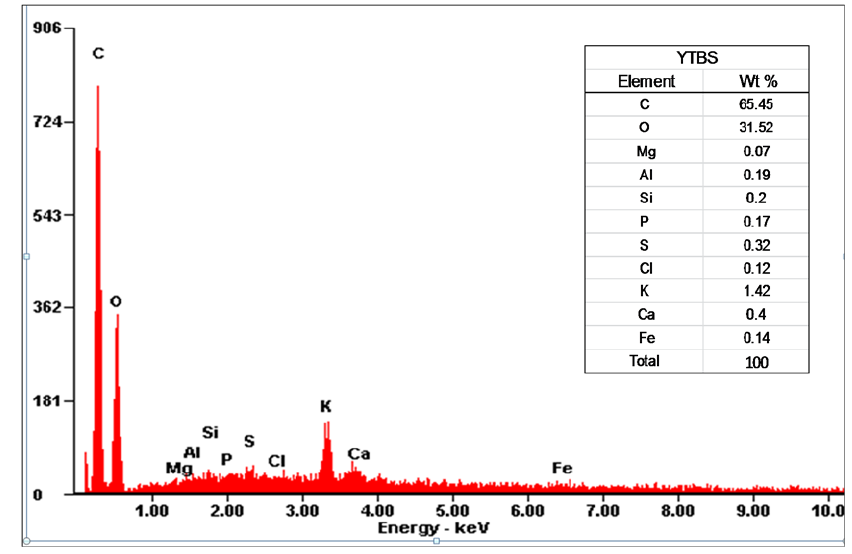
Figure 4. Energy dispersive X ‐ ray analysis (EDX) spectrum of YTBS residue adsorbent.